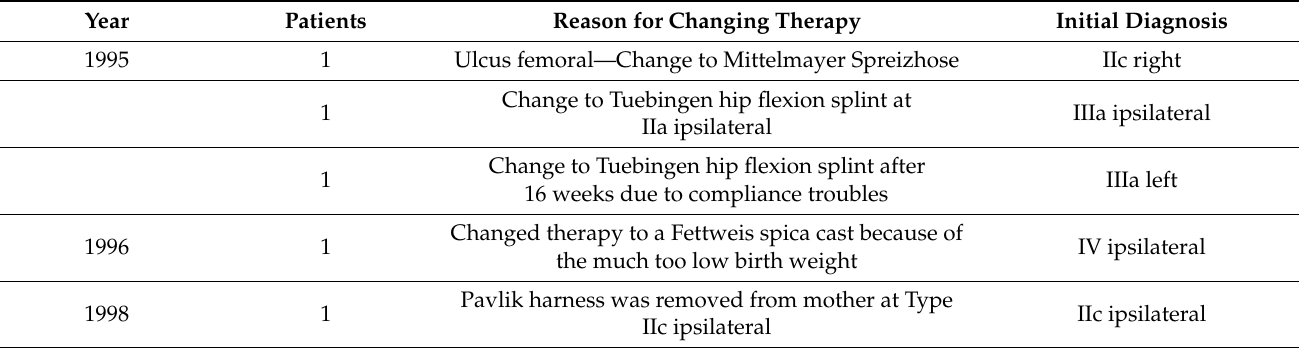
Table 2. Number of therapy dropouts by year and